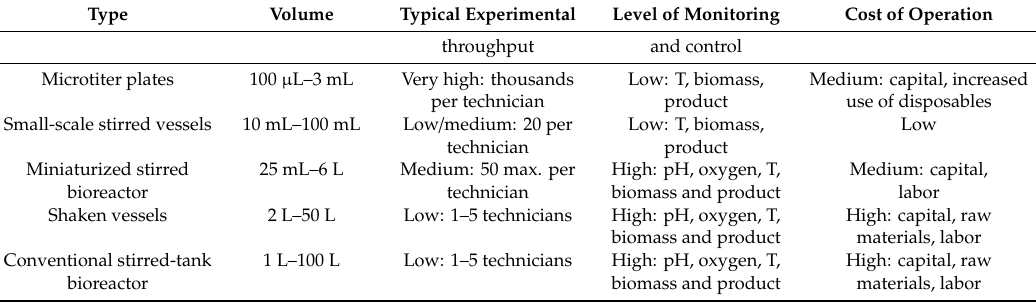
Table 1. Summarized conventional and high-throughput equipment